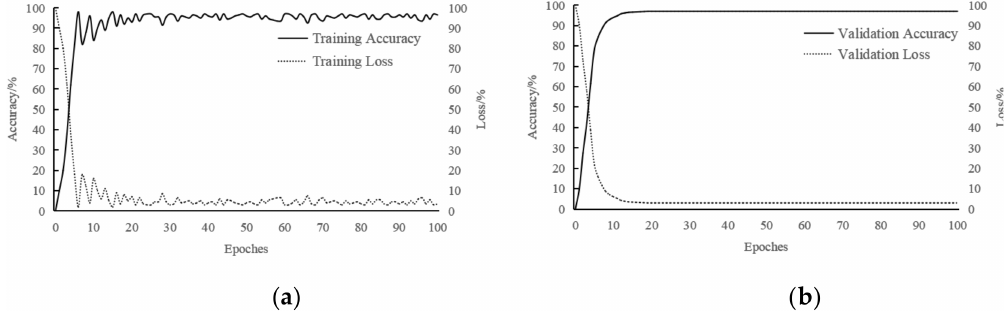
Figure 7. Training and validation results. ( a ) Training accuracy, ( b ) Validation